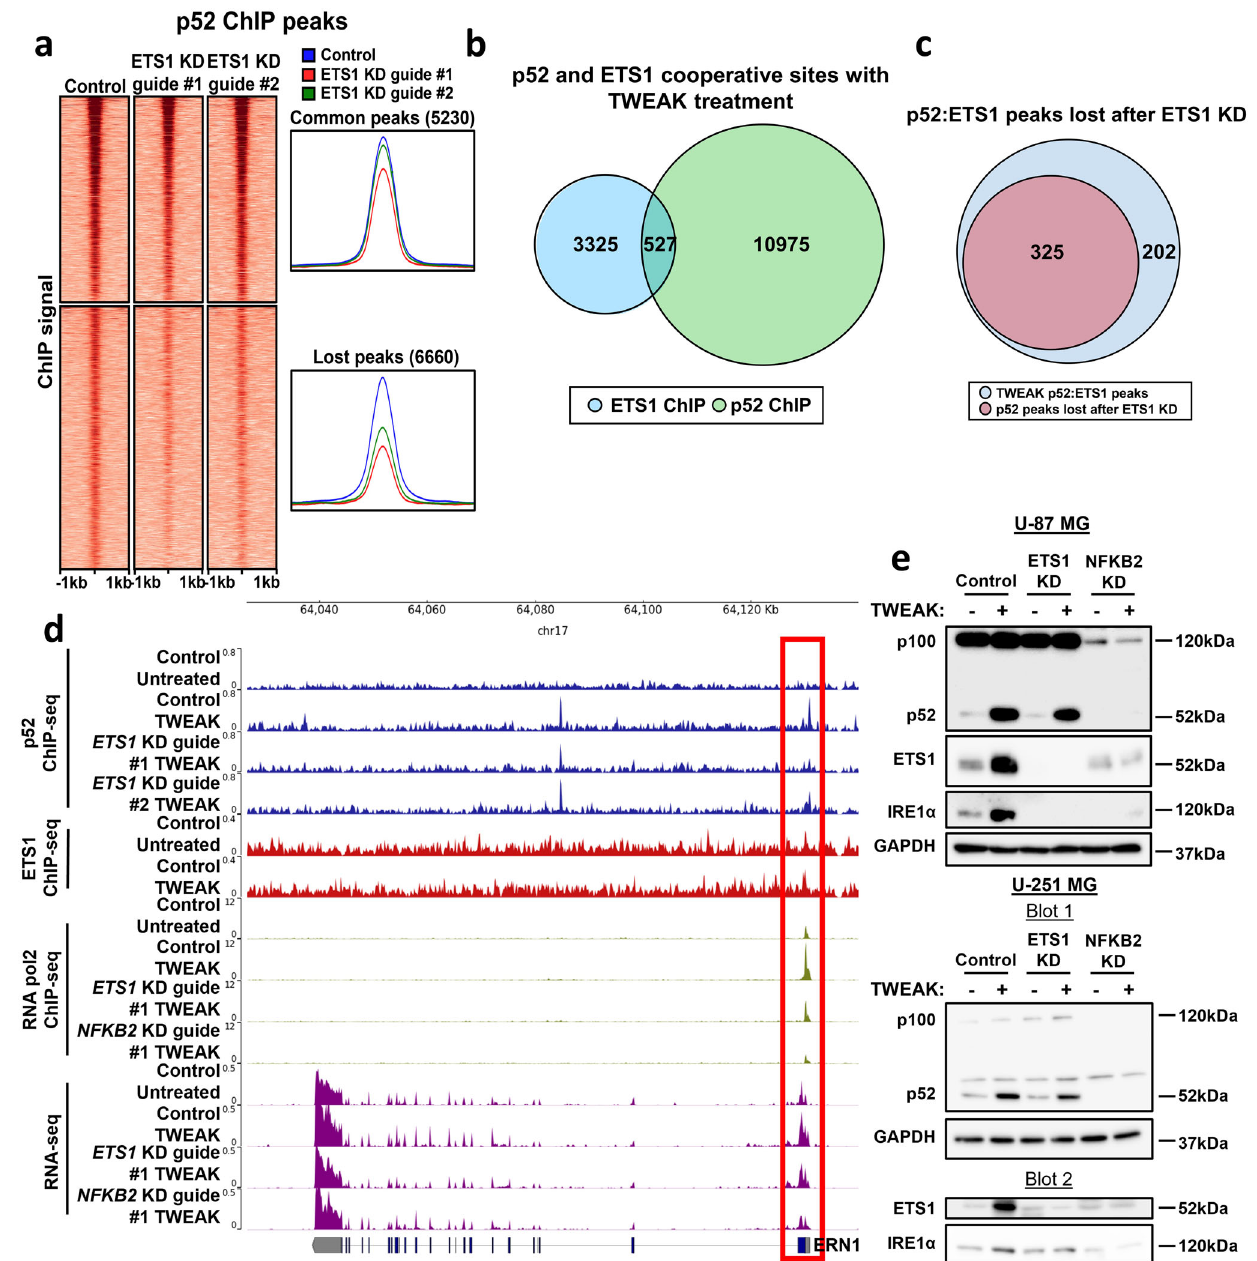
Fig. 4 ETS1 regulates the genome-wide binding of p52. a DNA binding dynamics of p52 in TWEAK-treated U-87 MG cells following ETS1 KD. Venn diagram depicting b the number of cooperative sites between p52 and ETS1, and c the number of p52:ETS1 co-binding sites lost following ETS1 KD. d RNA- seq tracks and p52, ETS1 and RNA pol II ChIP-seq tracks at the ERN1 promoter following NF- κ B/p52 activation as well as NFKB2 and ETS1 KD. Genomic changes observed at the ERN1 promoter are marked in a red box. GRCh38 assembly was used. e p100/p52, ETS1 and IRE1 α protein expression analysed by western blotting in U-87 MG and U-251 MG cell lines following NF- κ B/p52 activation as well as NFKB2 and ETS1 KD. The western blot involving U-251 MG cells was run over two blots at the same time and loaded with the same amount of protein. The proteins probed on each blot are indicated under Blot 1 and Blot further investigated the direct cooperative role of TWEAK-driven p52:ETS1 and demonstrated its capacity to regulate and drive glioma progression. Intriguingly, we found that NF- κ B-driven ETS1 regulated p52 DNA binding predominantly through indirect means, highlighting an overall complex regulatory rela- tionship between these two TFs. Hence, our results emphasise the relevance of non-canonical NF- κ B activation and ETS1 in glioma progression, thereby highlighting the immense potential of tar- geting the p52-ETS1 regulatory axis in cancer therapy.